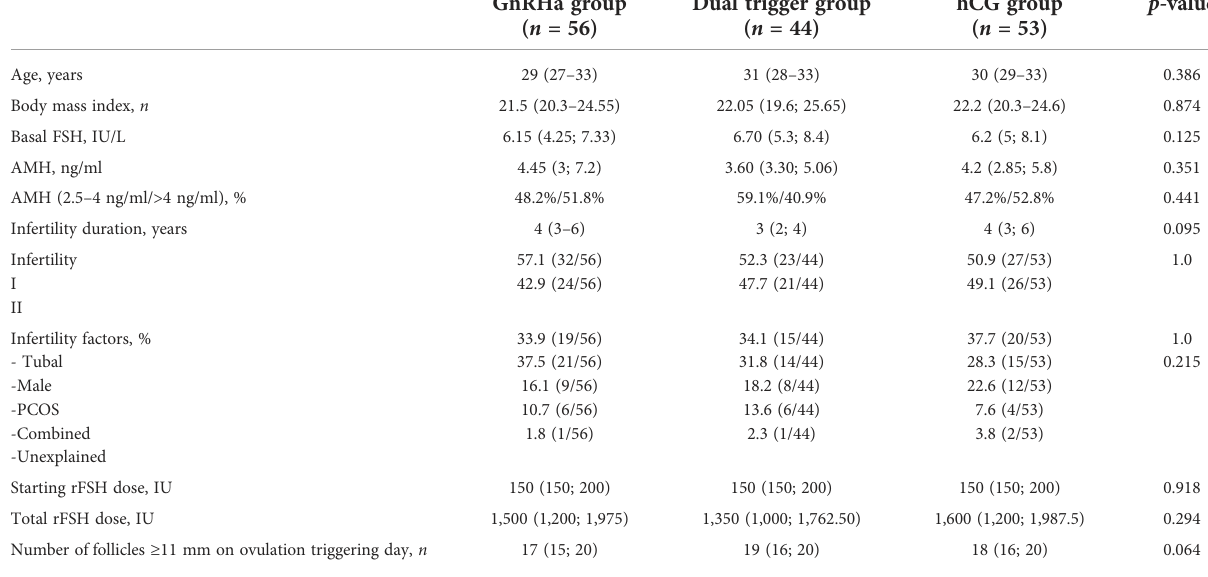
TABLE 1 Demographic and stimulation